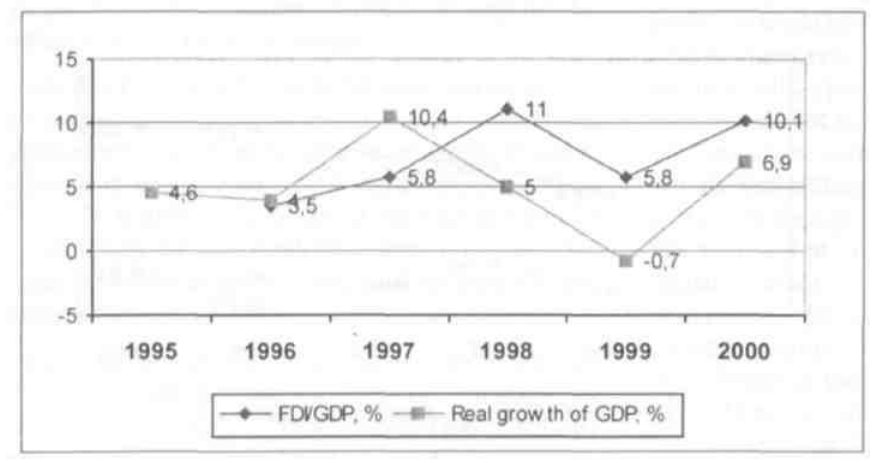
Fig 3. Analysis of Relationship Between Growth of FDI Measured as FDI/GDP, (%) and Real Growth of GDP, (%) in Estonia